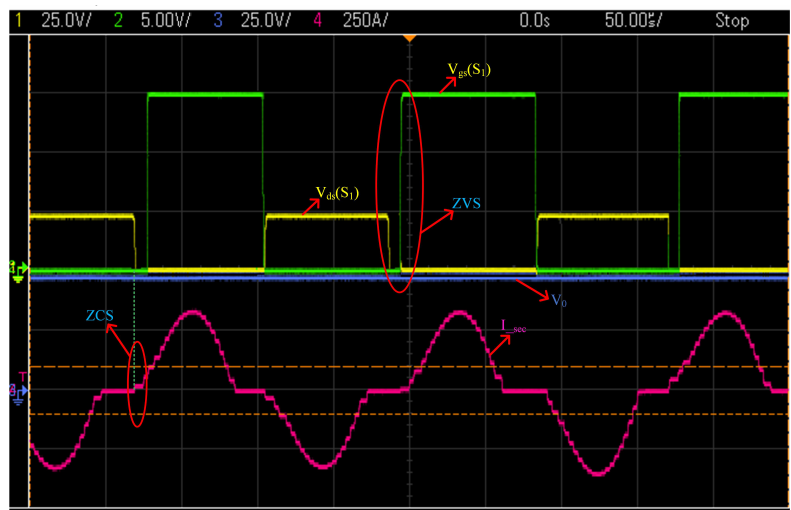
Figure 11. Experimental waveforms of the V gs and V ds showing ZVS operation under the worst condition.